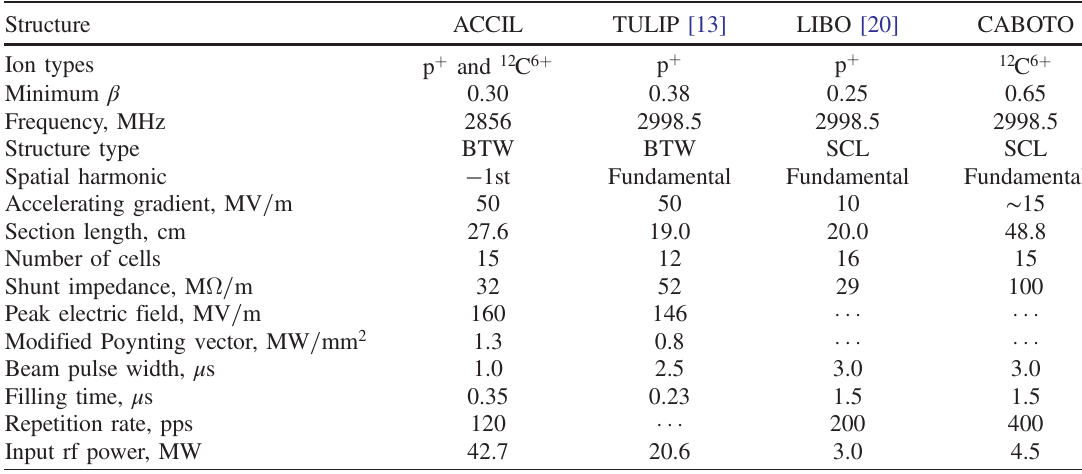
TABLE I. Comparison of developed high gradient structures for hadron therapy linacs.